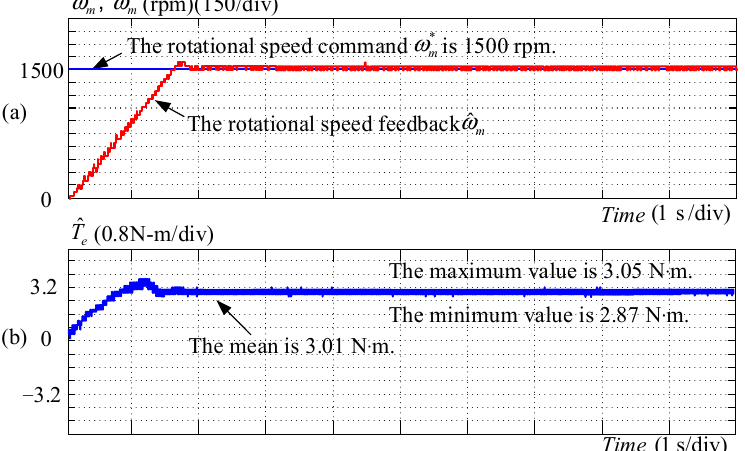
Figure 15. Measured rotational speed and electromagnetic torque of a three-phase permanent-magnet synchronous motor driven at 1500 rpm with a compensation strategy for harmonic components in induced EMF along the q-axis and d-axis: ( a ) measured rotational speed command ω ∗ m and rotational speed feedback ˆ ω m ; ( b ) measured electromagnetic torque ˆ T e